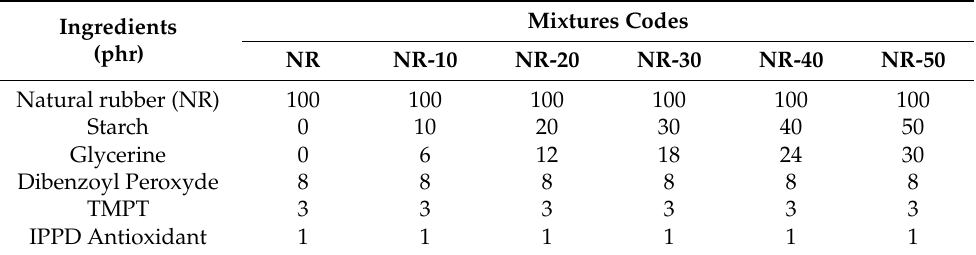
Table 2. The recipes used in obtaining